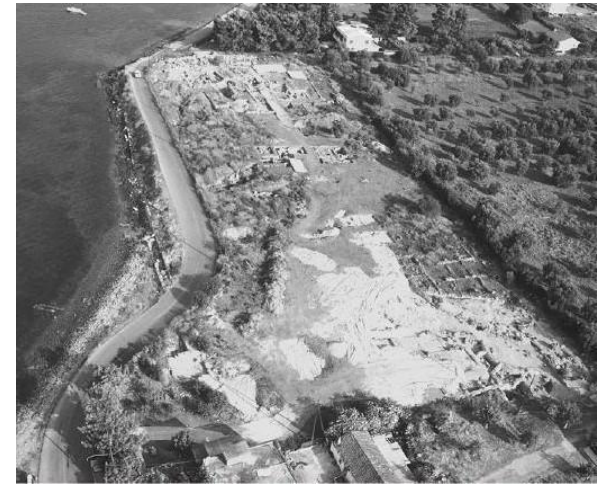
Figure 2. Aerial view (southeast aspect) of the site of Halai © J.